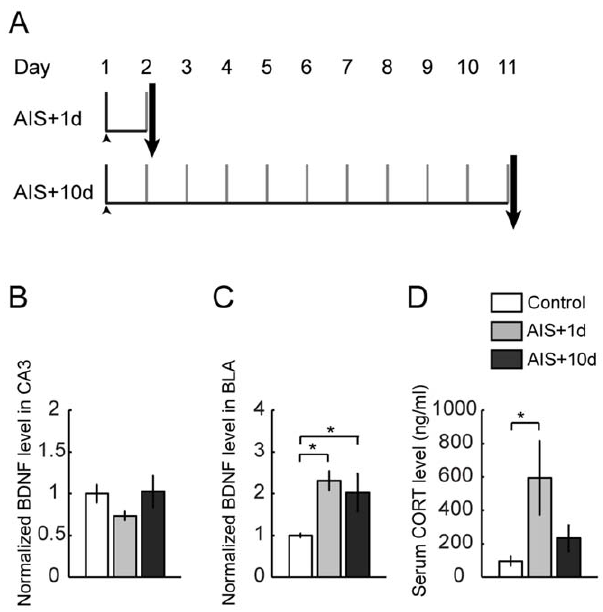
Figure 3. Acute stress modulates BDNF profile differentially in CA3 and BLA. Data are presented as mean 6 SEM. A Experimental design of acute stress (AIS + 1d) and recovery for 10 days from acute stress (AIS + 10d). B BDNF expression in area CA3 in response to acute stress. Acute stress does not change the BDNF levels in CA3 (Control, n=9; AIS + 1d, n=9; AIS + 10d, n=6, F (2,21) =2.11, p . 0.05). C Acute stress up regulates BDNF expression in BLA and this up regulation persists even after recovery (Control, n=6; AIS + 1d, n=5; AIS + 10d, n=6, F (2,14) =4.82, p , 0.05). BDNF expression profile was normalized to respective control levels and evaluated by Fisher’s post-hoc . D Effect of acute stress and recovery from acute stress on serum corticosterone levels (Control, n=11; AIS + 1d, n=5; AIS + 10d, n=6, Kruskal-Wallis ANOVA, x 2 (2) =10.01, p , 0.05, Mann-Whitney post-hoc, p , 0.05). Signif- icant differences *, p , 0.05.